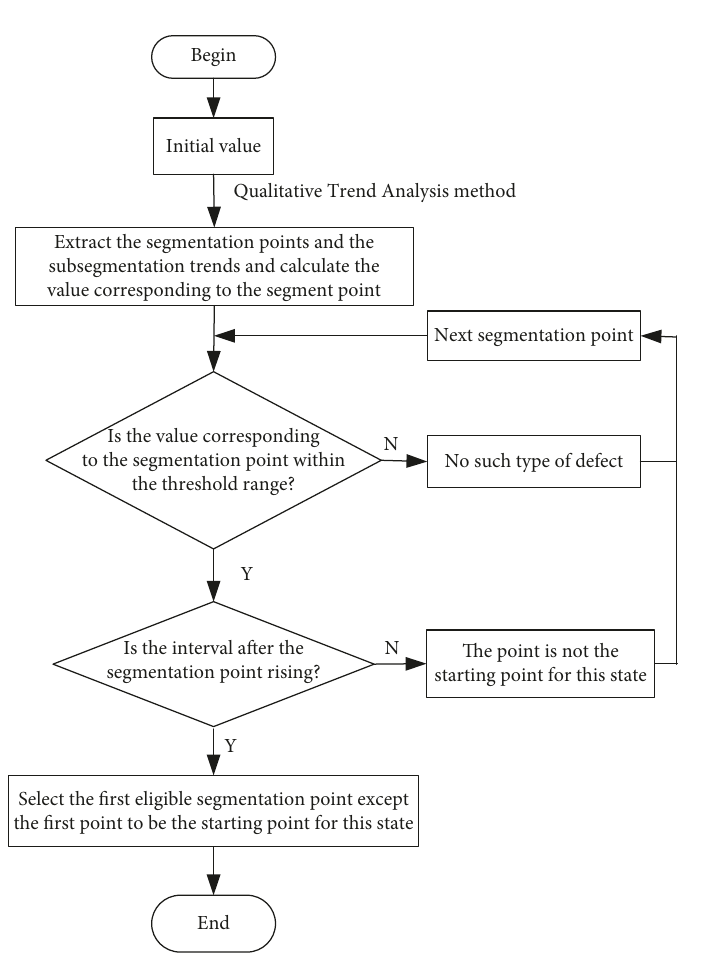
Figure 3: Defect judgment fl